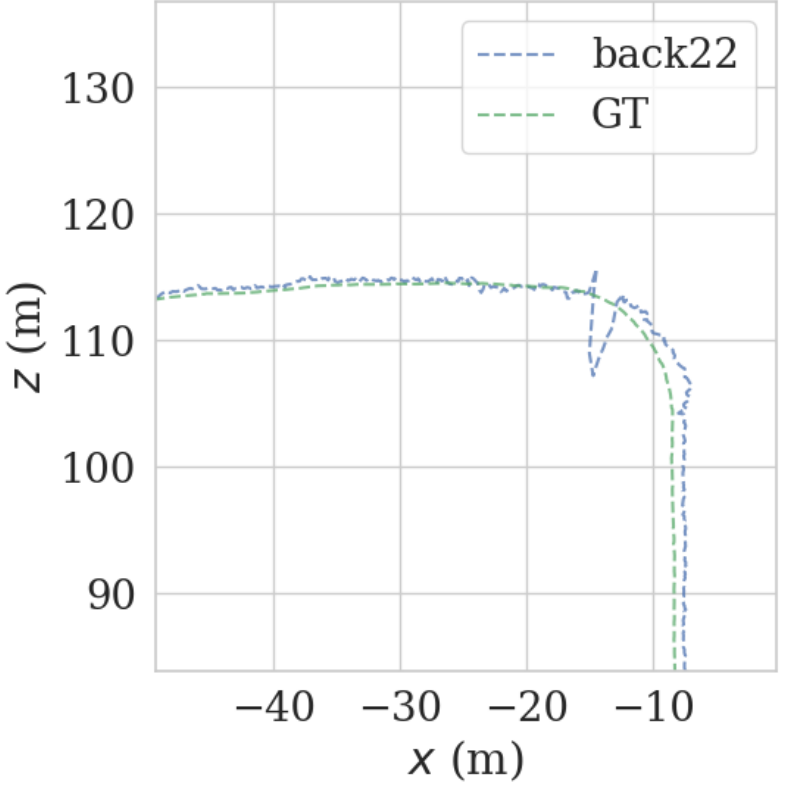
Figure 14. Track error using back LiDAR data at